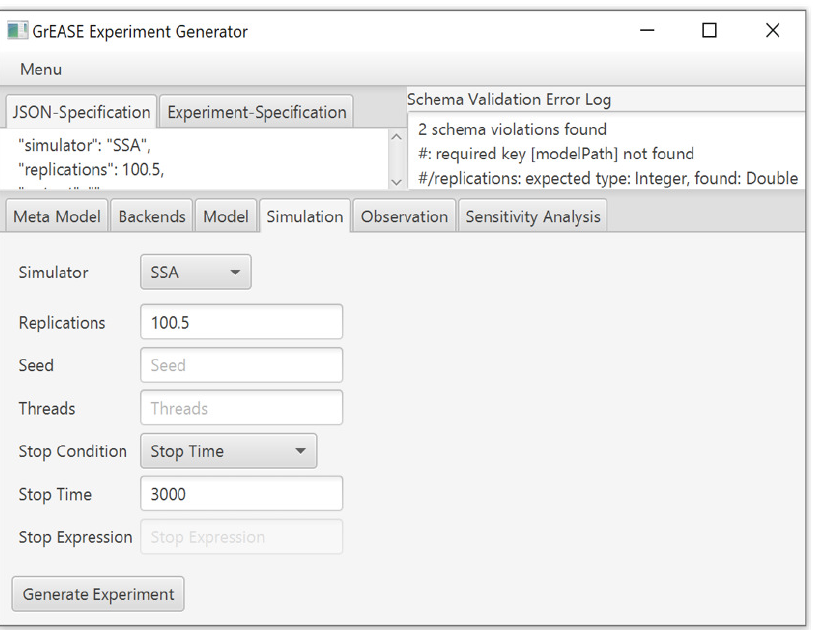
Figure 3. Screenshot of the experiment generation GUI. For a given meta model, and depending on the provided inputs, new input fields are generated. Validation errors are reported at the top right if the inputs do not conform to the meta model. In this example, a double value was entered for the number of replications, but an integer value was expected. Furthermore, the model path has not been specified yet. The generated experiment specifications (tool-independent and tool-specific) are displayed at the top